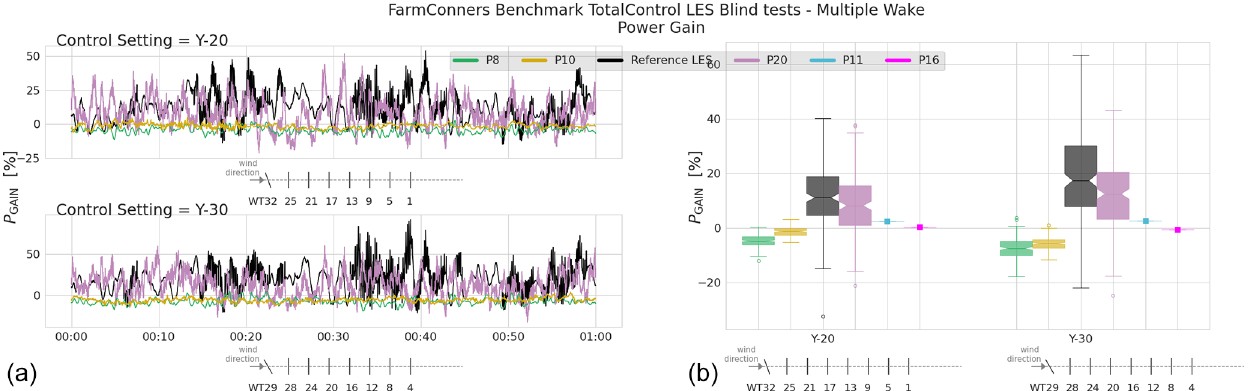
Figure 24. TotalControl LES blind tests, power gain estimations, P GAIN , for multiple wakes under the upstream wake steering for the eight- turbine configurations with 5D spacing (WT32–WT4 with 20 ◦ yaw and WT29–WT1 with 30 ◦ yaw at the upstream turbines). (a) Time series of P GAIN , illustrated at the submitted frequency by the participants. (b) The distribution of the P GAIN within the 1h blind test period, for both 20 and 30 ◦ anticlockwise upstream yaw misalignment WFFC